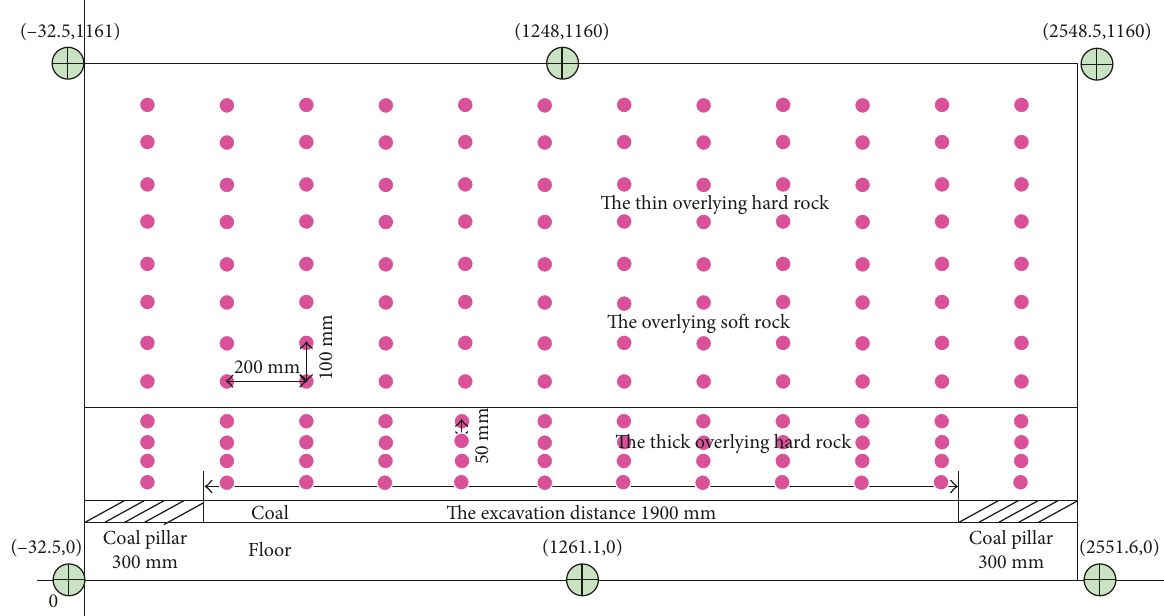
Figure 7: The arrangement of the control reference points and the colour points.